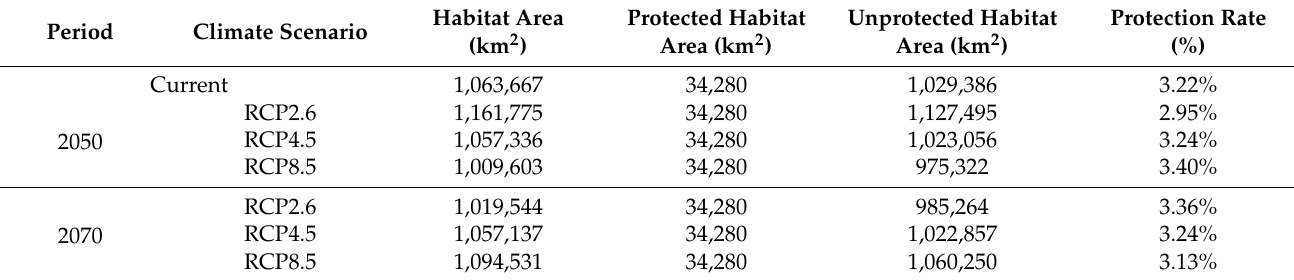
Table 3. Summary of currently protected areas and distribution of occupied breeding grounds.